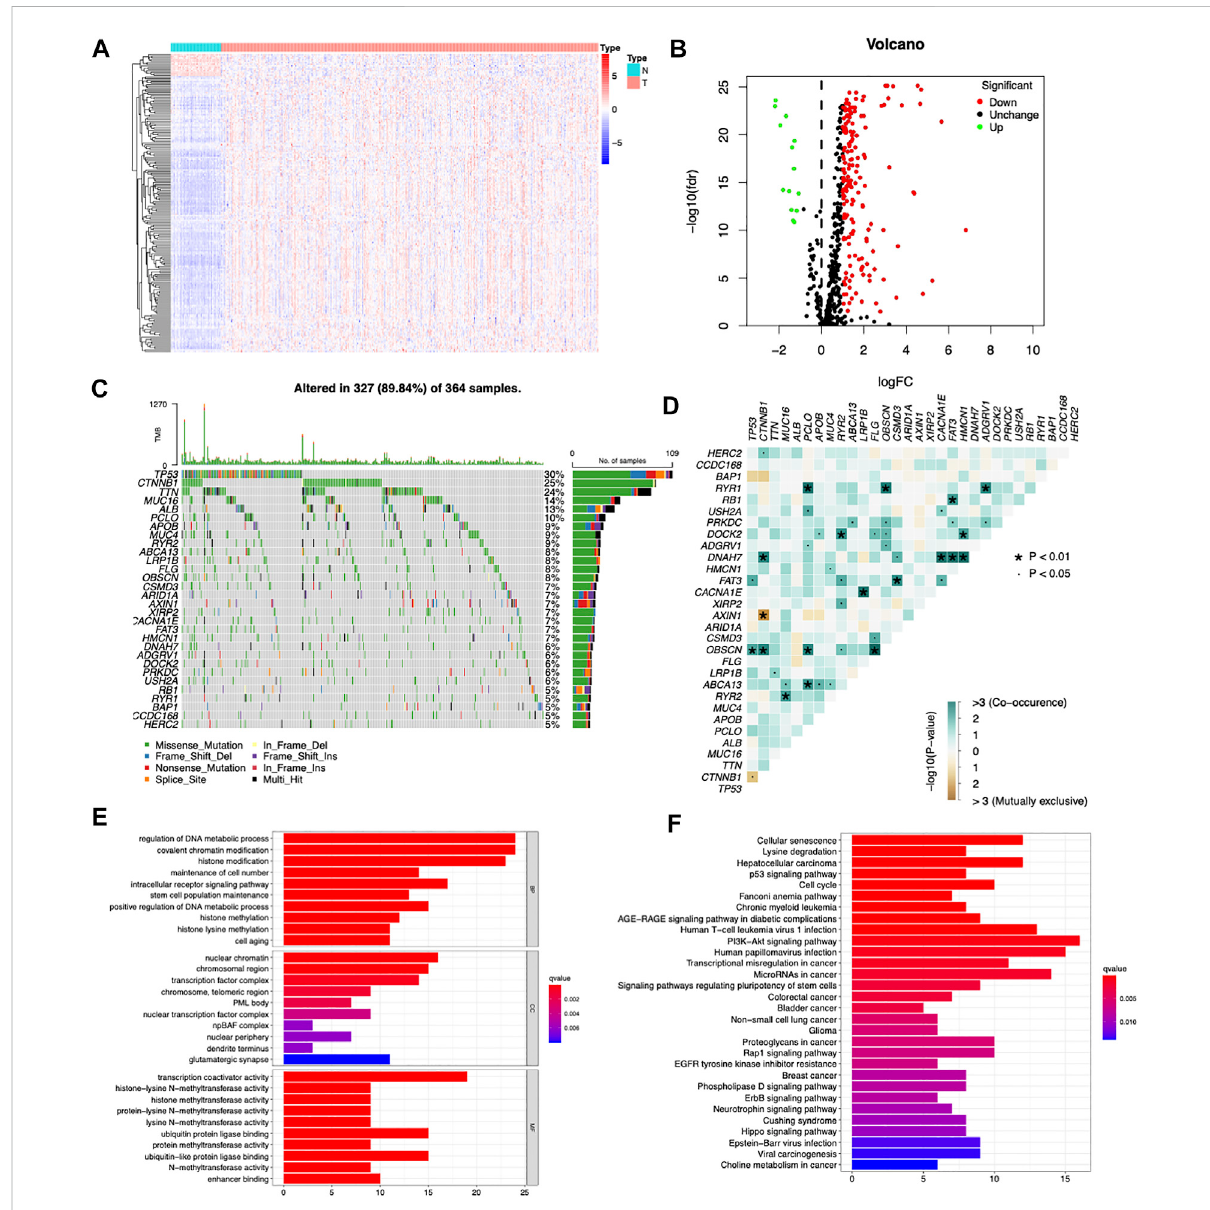
FIGURE 1 Searching differentially expressed CDGs in the TCGA cohort. (A) Heatmap of differentially expressed CDGs between HCC and normal tissues. (B) VolcanoplotofdifferentiallyexpressedCDGsbetweenHCCandnormaltissues. (C) Mutationspectrumofthetop30mostfrequentlymutatedDE CDGs in the TCGA-LIHC cohort, with each column representing one patient and the percentage on the right side representing the corresponding gene mutation rate. (D) Interactions and crosstalk between mutated genes in the TCGA-LIHC cohort. (E) GO enrichment analysis of the upregulated DE CDGs. (F) KEGG enrichment analysis of the upregulated DE